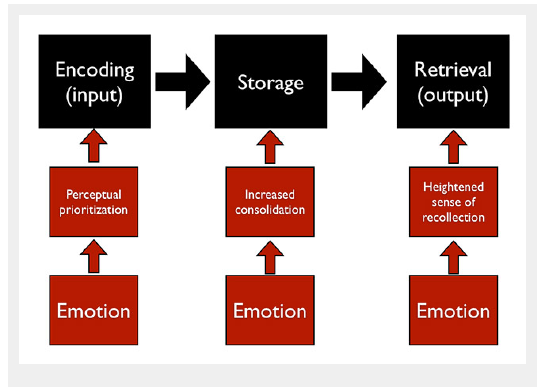
Schematic illustration of the impact of emotion on three different stages of memory processing: (1) By prioritising the perception of emotionally relevant information, encoding of this information may be strengthened. (2) By modulating the consolidation process of emotional information via increases in arousal, emotional information may form more robust memory traces. (3) By enhancing the subjective recollective experience of emotional information, emotional memories may become more central to the planning of current behaviour (see text for more